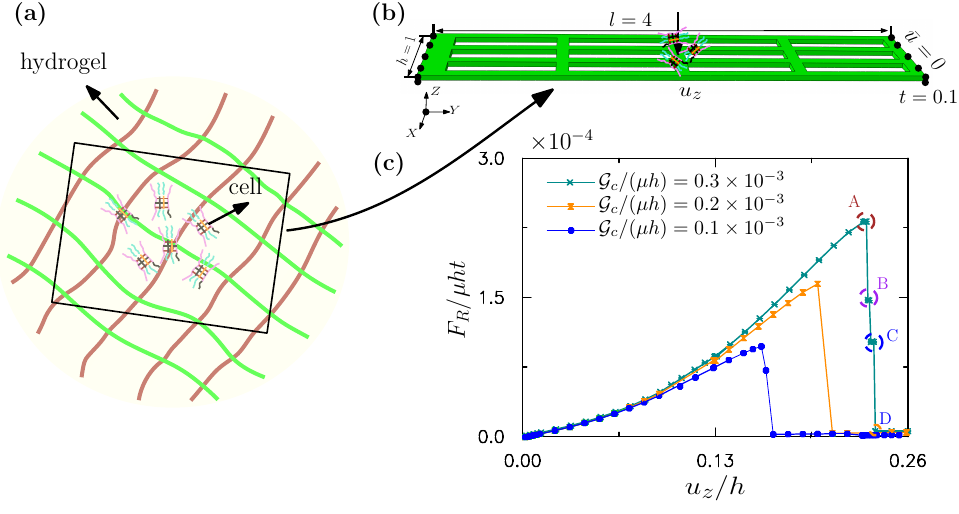
Figure 11. Fracture of hydrogel matrix for cell culture. ( a ) Schematics of cell culture on the hydro- gel matrix. ( b ) Geometric dimensions and boundary conditions of the simplified model. ( c ) The normalized reaction force vs. the normalized